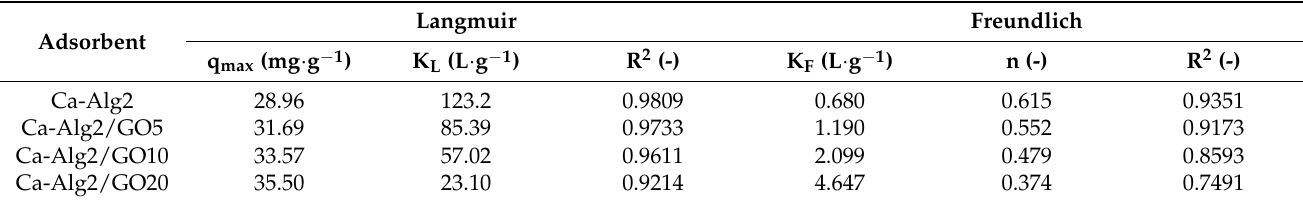
Table 8. Langmuir and Freundlich isotherm constants for FMTD adsorption onto Ca-Alg2 and Ca-Alg2/GO beads. Langmuir Adsorbent